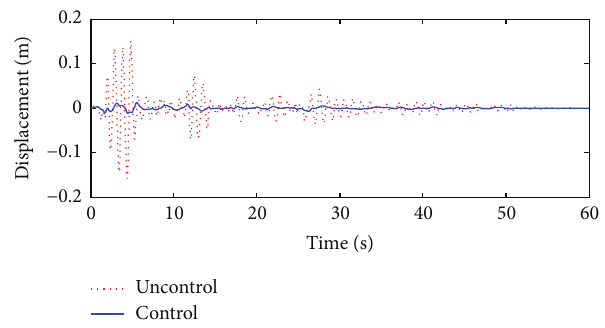
Figure 5: Time history graphs of displacement for the fifth floor for uncontrolled and synchronized control coupled with 𝐻 2 / LQG algorithm in El Centro Earthquake (1940).